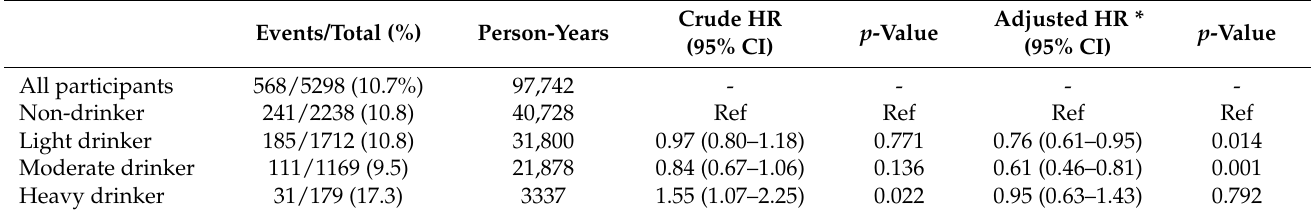
Table 2. The association between alcohol-consumption trajectory classes and all-cause